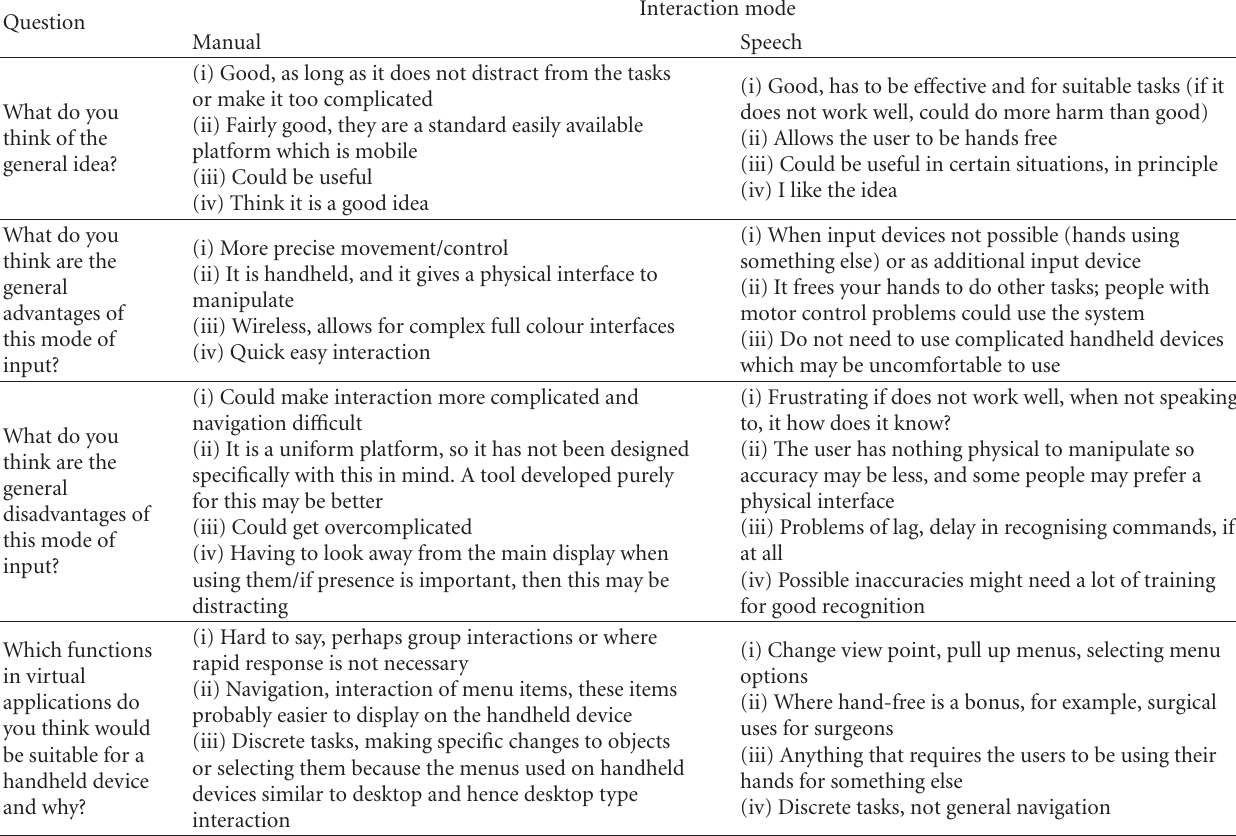
Table 2: Initial impressions of manual and speech